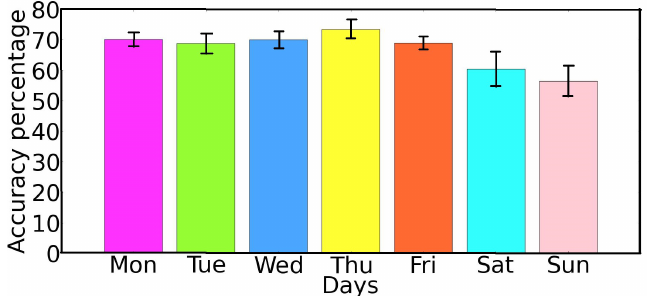
Figure 9. Average trajectory density prediction accuracy per each